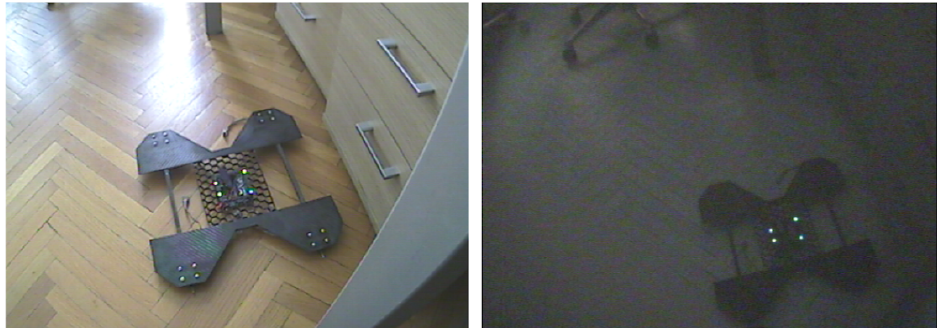
Figure 3. Example of analog camera IR filtering used in the original docking concept ( left ), no filter; ( right ) IR filtering film applied. Images are of four IR LED markers mounted on a test robot frame.